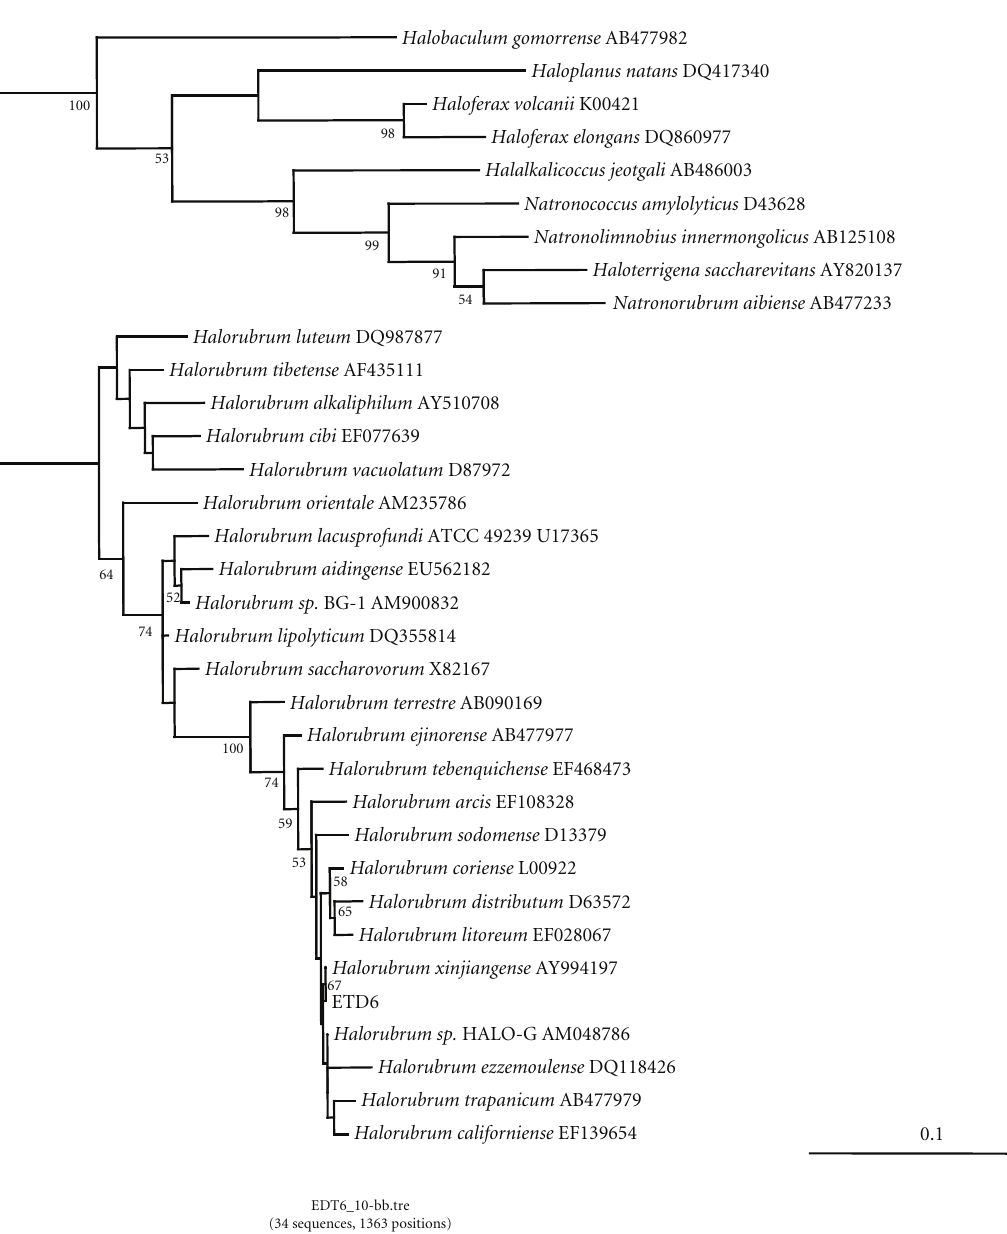
Figure 4: Maximum likelihood phylogenetic tree of 66 halobacteriales sequences showing the position of strain ETD6 among the species of genus Halorubrum and other genera of extremely halophilic archaea. The tree was reconstructed using Treefinder [49] with a Jukes and Cantor model. Values at nodes represent bootstrap values computed with Treefinder (100 replicates of the original dataset). The scale bar represents the average number of substitutions by site. Halorubrum sp. BG-1 AM900832 correspond to Halorubrum kocurii ; Halorubrum sp. HALO-G AM048786 correspond to Halorubrum chaoviator